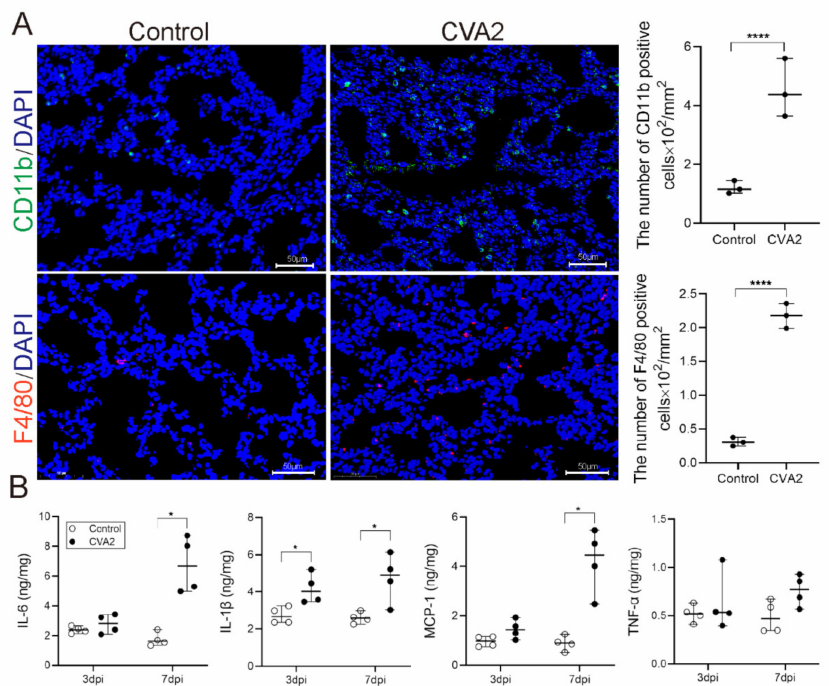
Figure 5. Inflammatory cell infiltration and cytokines expression induced by CVA2 infection. ( A ) CD11b and F4/80 positive cells in lung tissues were stained by IF and quantified by Image J software ( n = 3 per group). ( B ) The expression levels of some cytokines (IL-6, IL-1 β , MCP-1, and TNF- α ) in tissue lysates of lungs by ELISA. n = 4 per group, data represent the median with range. * p < 0.05;